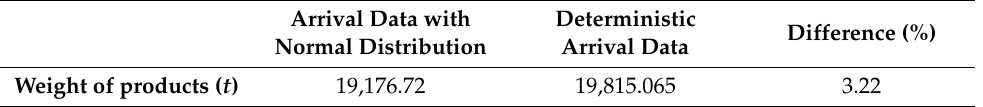
Table 12. Deviation percentage between deterministic and stochastic model. Arrival Data with Normal